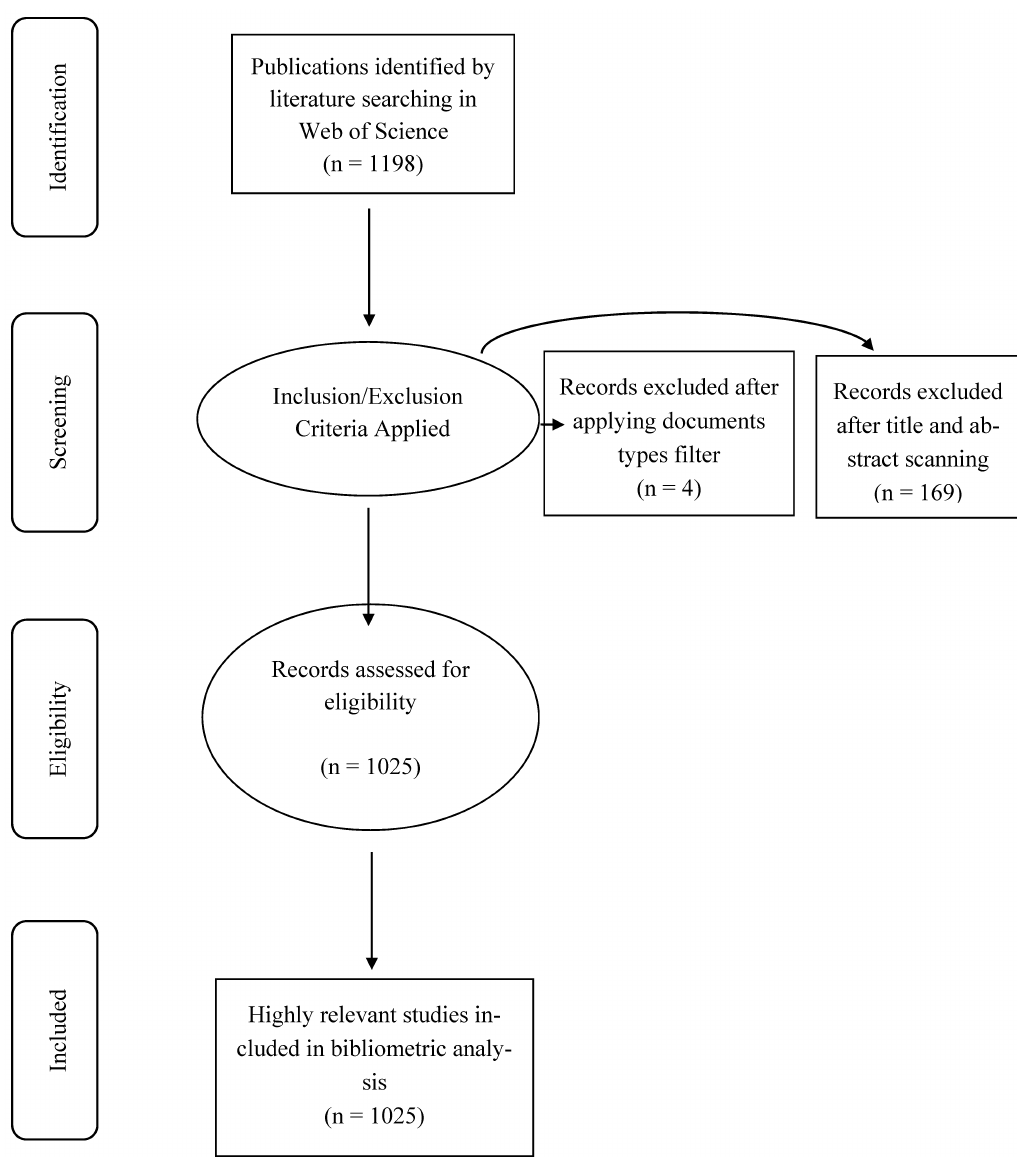
Figure 1. Four-phase flow chart of data extraction and filtration process.